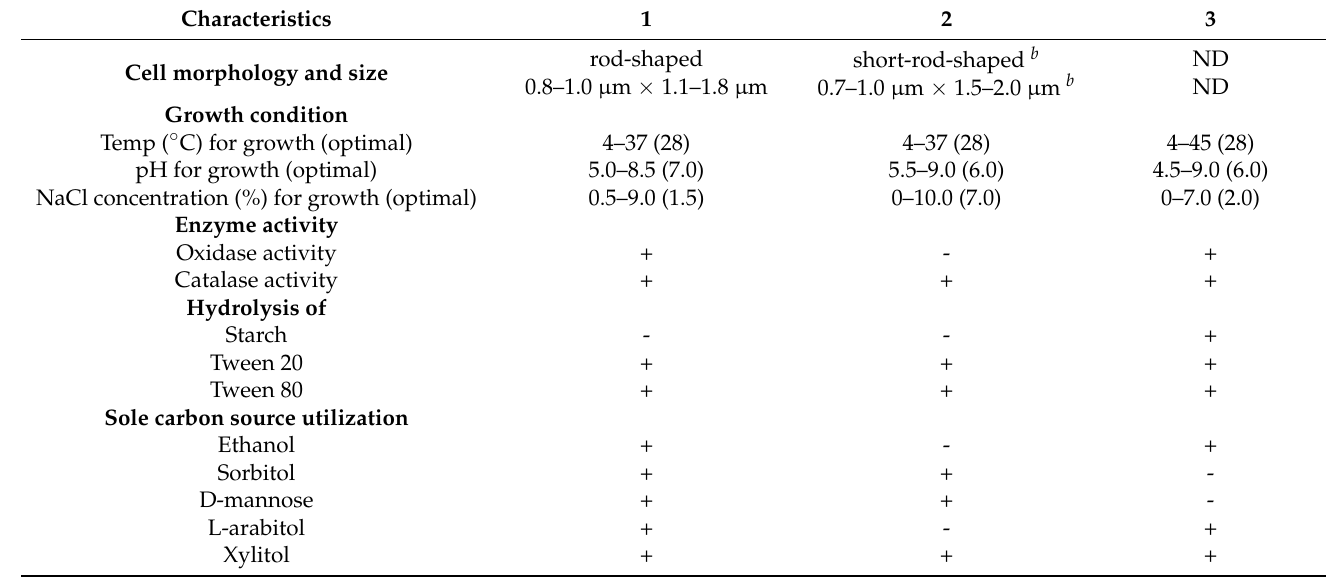
Table 2. Characteristics comparison between strain gcc21 T and its related strains a